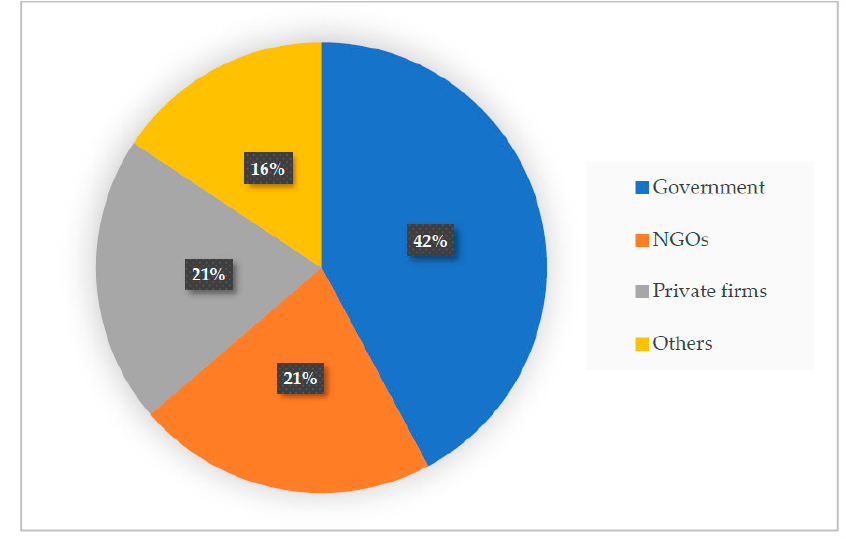
Figure 4. Percentage of the 102 valid samples classified by the type of working places.